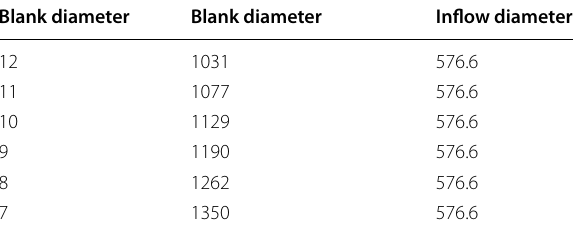
Table 4 Blank diameter according to blank thickness (mm) Blank diameter